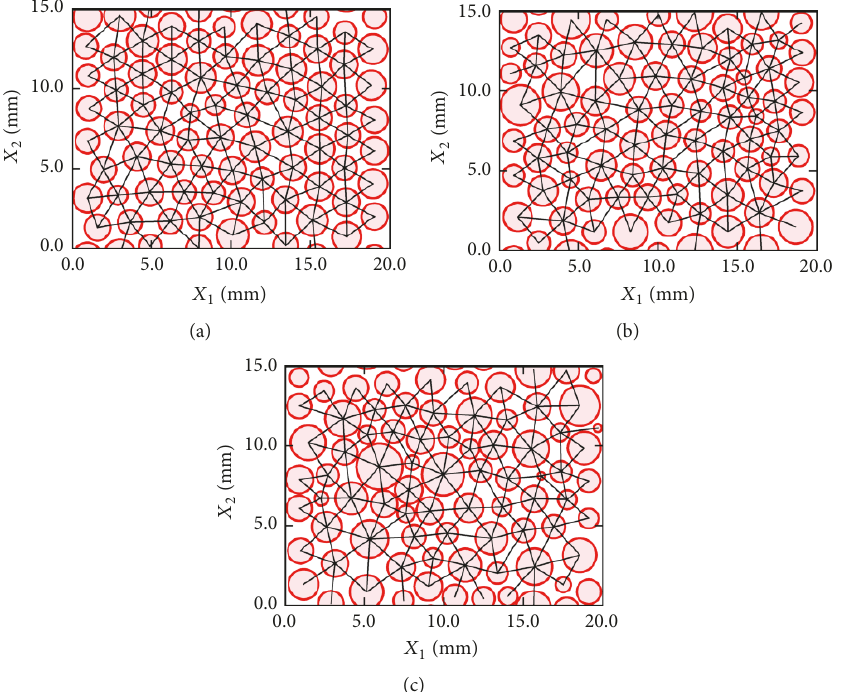
Figure 9: Computational unit cells A, B, and C (from (a) to (c)). Black lines in microstructure plots correspond to Delaunay edges that have been used to generate pore-throat size histograms (Table